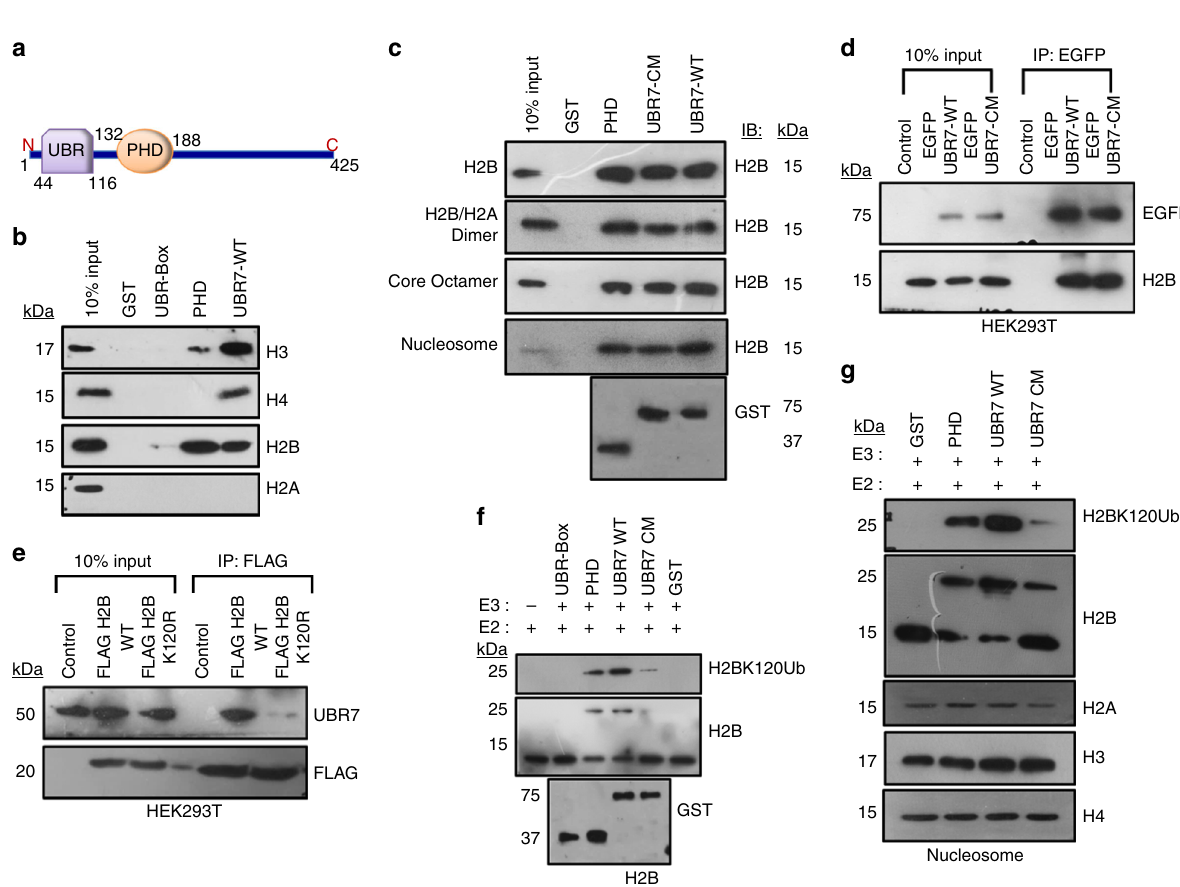
Fig. 1 UBR7 is a histone H2B ubiquitin ligase. a Schematic of the domain organization of UBR7. b Immunoblots showing the in vitro interaction of puri fi ed UBR7 with recombinant histones H3, H4, H2B, and H2A. c Interaction of UBR7 full-length wild-type (WT) or catalytic-mutant (CM) with recombinant H2B, H2A/H2B dimer, core octamer, or puri fi ed nucleosomes from HeLa cells. d Ex vivo interaction of H2B with UBR7 WT or CM in HEK293T cells. e Ex vivo interaction of UBR7 with H2B WT or H2B mutant (K120R) in HEK293T cells. f , g In vitro ubiquitination assay with recombinant H2B ( f ), or puri fi ed nucleosomes from HeLa cells ( g algorithm in a 10-state model (Fig. 2k; see Methods) indicated its expression in The Cancer Genome Atlas Group (TCGA) breast cancer mRNA expression data 28 . This analysis revealed reduced UBR7 expression in triple-negative and basal-like breast